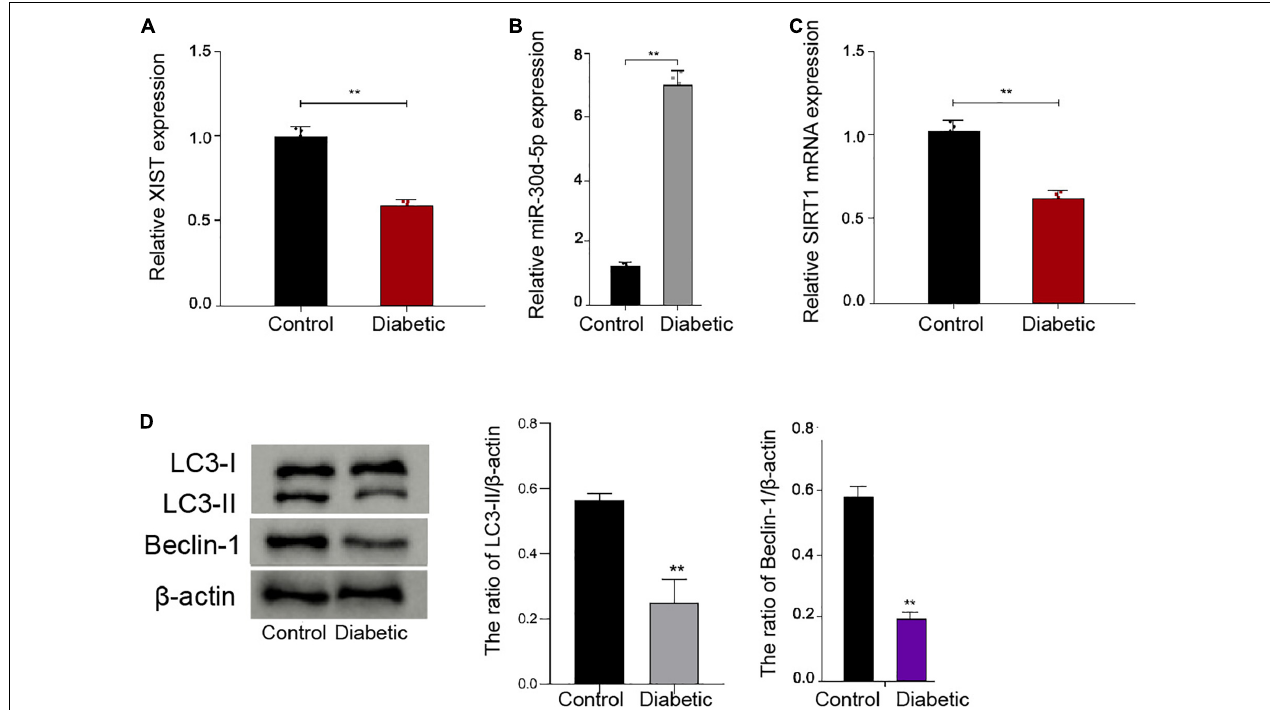
FIGURE 1 | The expression of XIST and SIRT1 and autophagy are decreased, and the expression of miR-30d-5p is increased in the trigeminal sensory neurons of the diabetic mice. (A) The expression of XIST is measured by qPCR assays in the trigeminal sensory neurons of the diabetic mouse model. (B) The expression of miR-30d-5p is detected by qPCR assays in the trigeminal sensory neurons of the diabetic mouse model. (C) The expression of SIRT1 is examined by qPCR assays in the trigeminal sensory neurons of the diabetic mouse model. (D) The expression of LC3I, LC3II, and Beclin-1 is assessed by Western blot analysis in the trigeminal sensory neurons of the diabetic mouse model. N = 6, mean ± SD, ** P < 0.01.